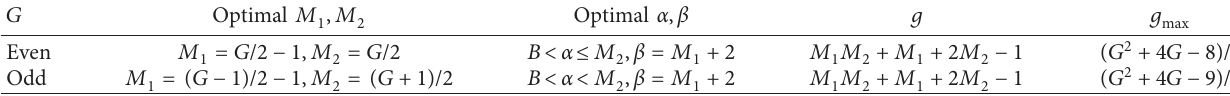
Table 1: Optimal configuration structure for EGNA.